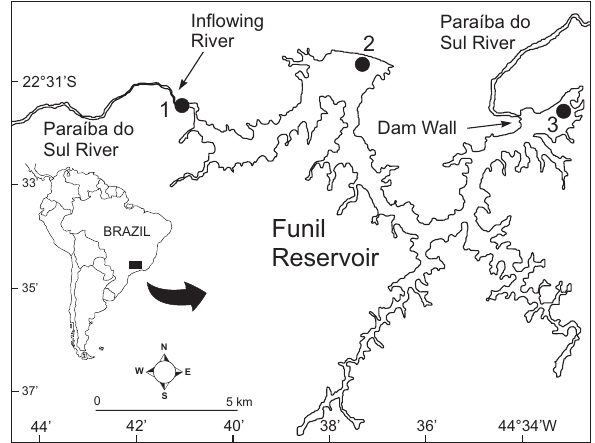
Figure 1. Studied area with indication of the sampled zones: river- ine (1), transition (2) and lentic